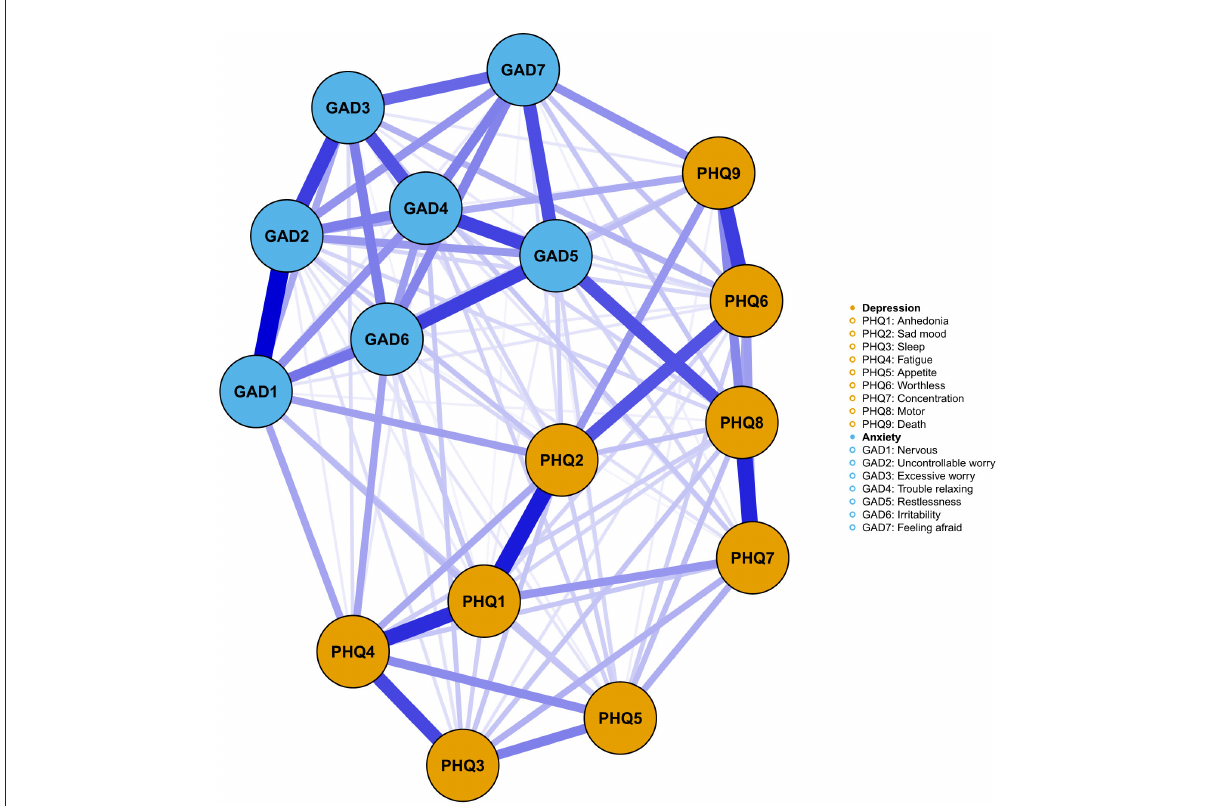
FIGURE1 The network of anxiety-depression symptoms. Orange nodes represented the depression symptoms, while blue nodes represented the anxiety symptoms. The thickness of the edges represented the strength of the association between two nodes, with higher thickness indicating stronger